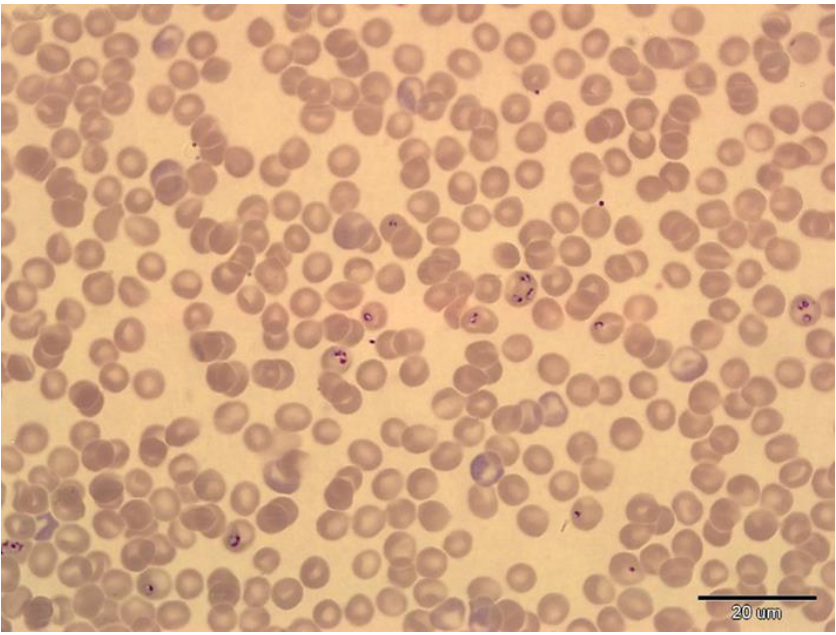
Figure 2. Babesia vesperuginis in a blood smear from a heavily infected Noctule bat female with acid – base imbalance in hibernation (Giemsa staining, magnification of 1000×). We obtained complete paired results of blood parameters during both deep hibernation (February) and the post-hibernation period (April/May) from 21 (10 males and 11 females) of the 50 bats sampled. The bats were divided according to sex and infection status (10 males and 11 females, 13 negative, 5 Trypanosoma -positive and 3 Babesia -positive). These data were used to evaluate the effect of blood parasites on the health of bats during hibernation and post-hibernation